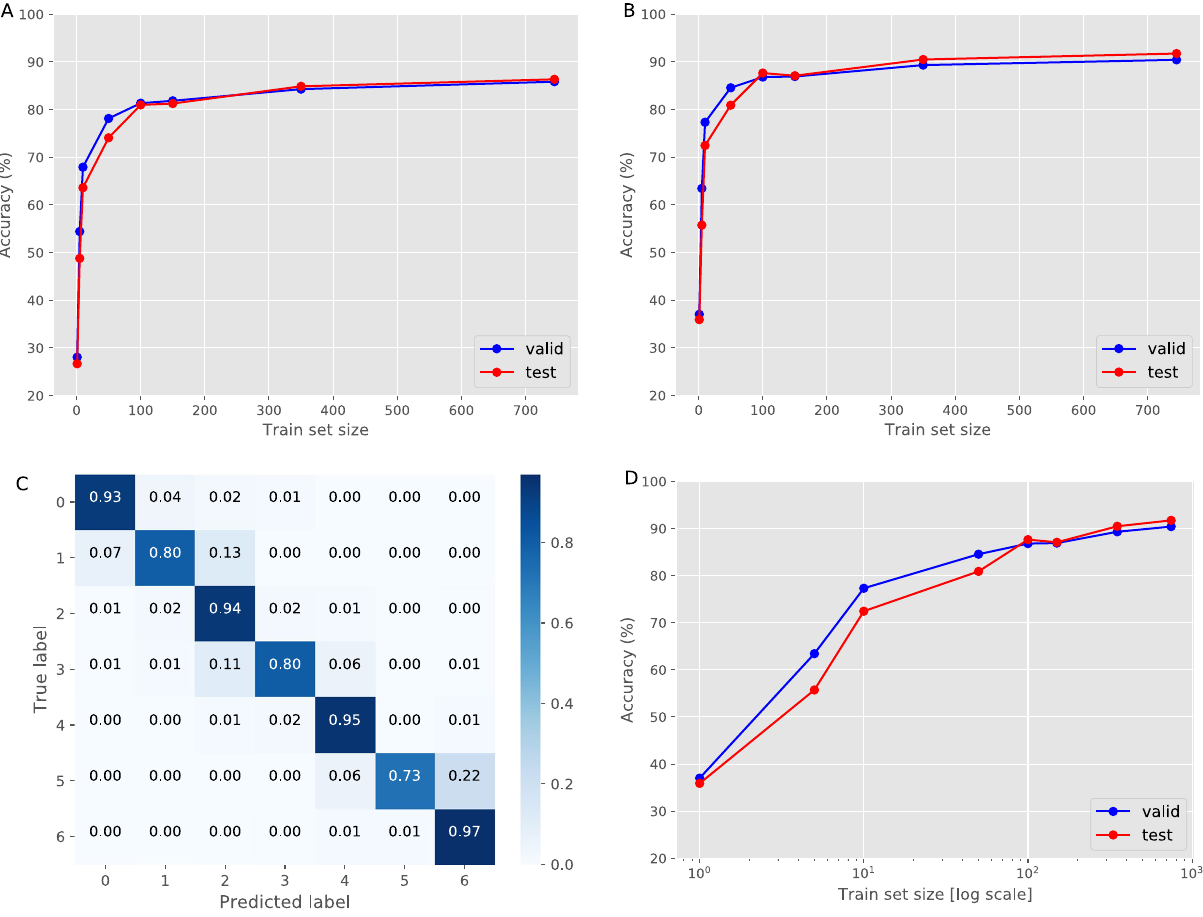
Figure 2. Asymptotic performance assessment. Accuracy values, measured on the validation and test sets, when training the models on an increasing number of videos (1, 5, 10, 50, 100, 150, 350, 745). ( A ) Accuracy for the short-term model. The log-scale version is available in Supplementary Fig. S1. ( B ) Accuracy for the long- term model. ( C ) The test set confusion matrix for the best long-term model. ( D ) Accuracy for the long-term model for a log-scale training set size.